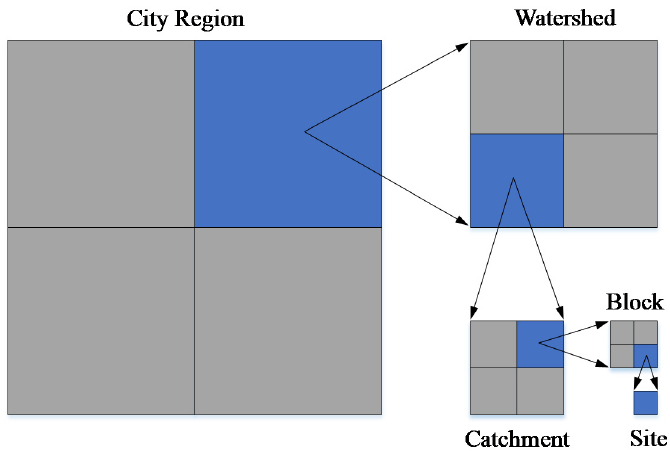
ff erent spatial